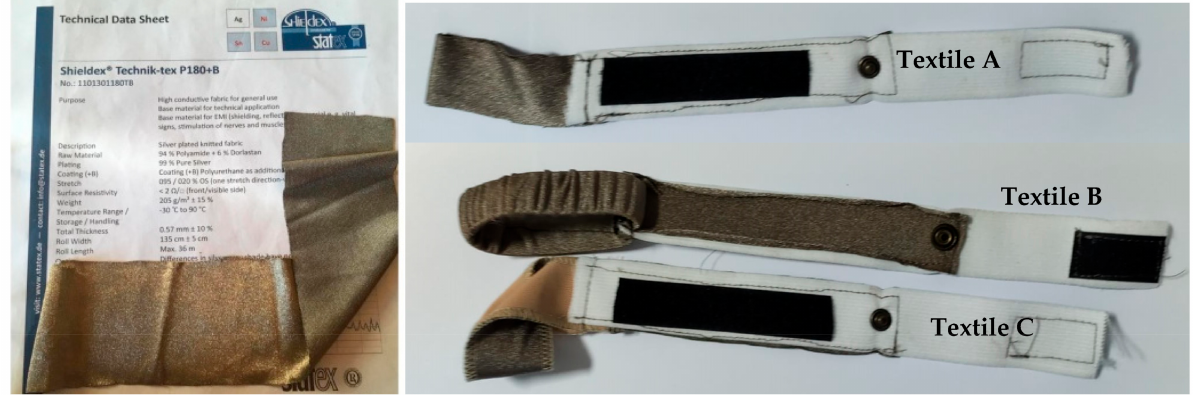
Figure 3. Photographs of the fabricated textile